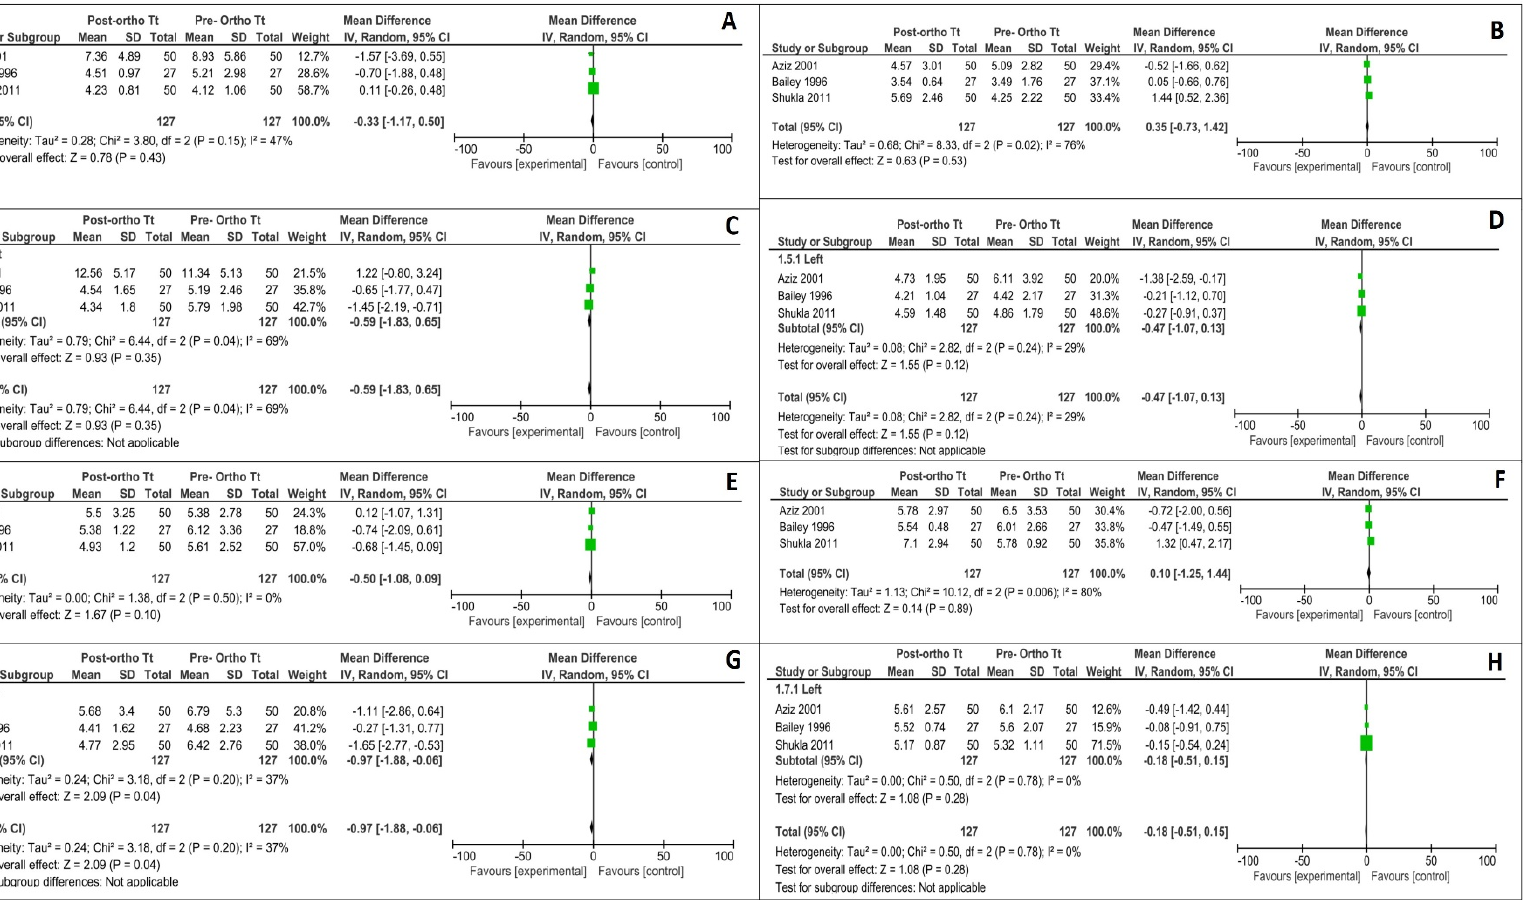
Figure 3. Meta ‐ analysis summarizing the effect of the orthodontic treatment on the anteroposterior dimensions. ( A ) Antero ‐ posterior changes between 1–2 rugae of right side (lateral); ( B ) Antero ‐ posterior changes between 1–2 rugae of right side (medial); ( C ) Antero ‐ posterior changes between 1–2 rugae of left side (lateral); ( D ) Antero ‐ posterior changes between 1–2 rugae of left side (medial); ( E ) Antero ‐ posterior changes between 2–3 rugae of right side (lateral); ( F ) Antero ‐ posterior changes between 2–3 rugae of right side (medial); ( G ) Antero ‐ posterior changes between 2–3 rugae of left side (lateral); ( H ) Antero ‐ posterior changes between 2–3 rugae of the left side (medial).